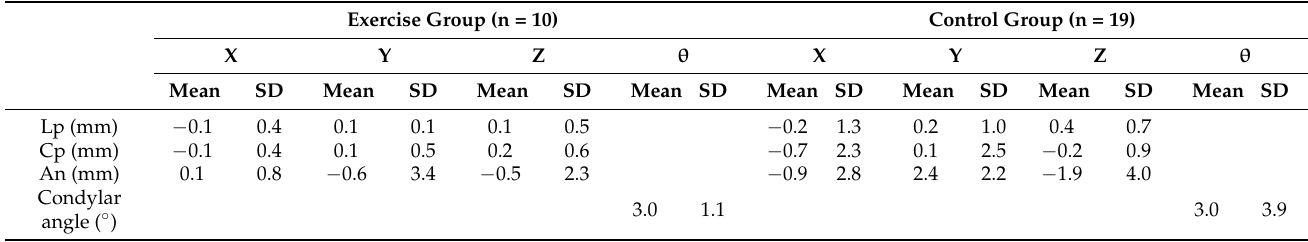
Table 3. Comparison between exercise group and control group of proximal bone fragment and axial condylar angle between T1 and T2.